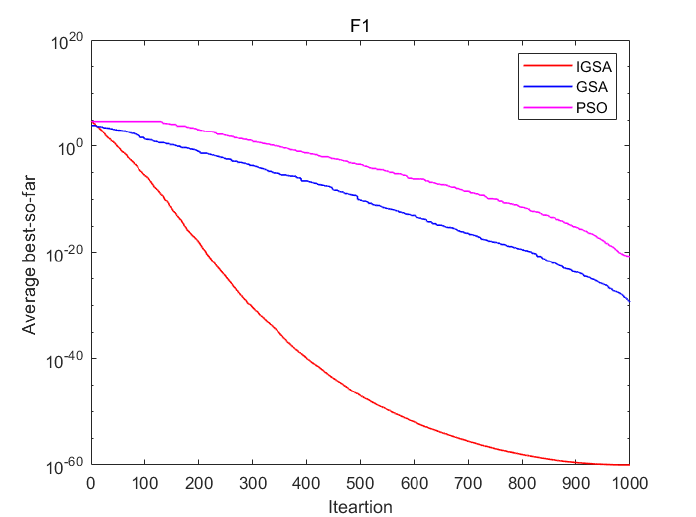
Figure 4. The convergence behavior of F 1